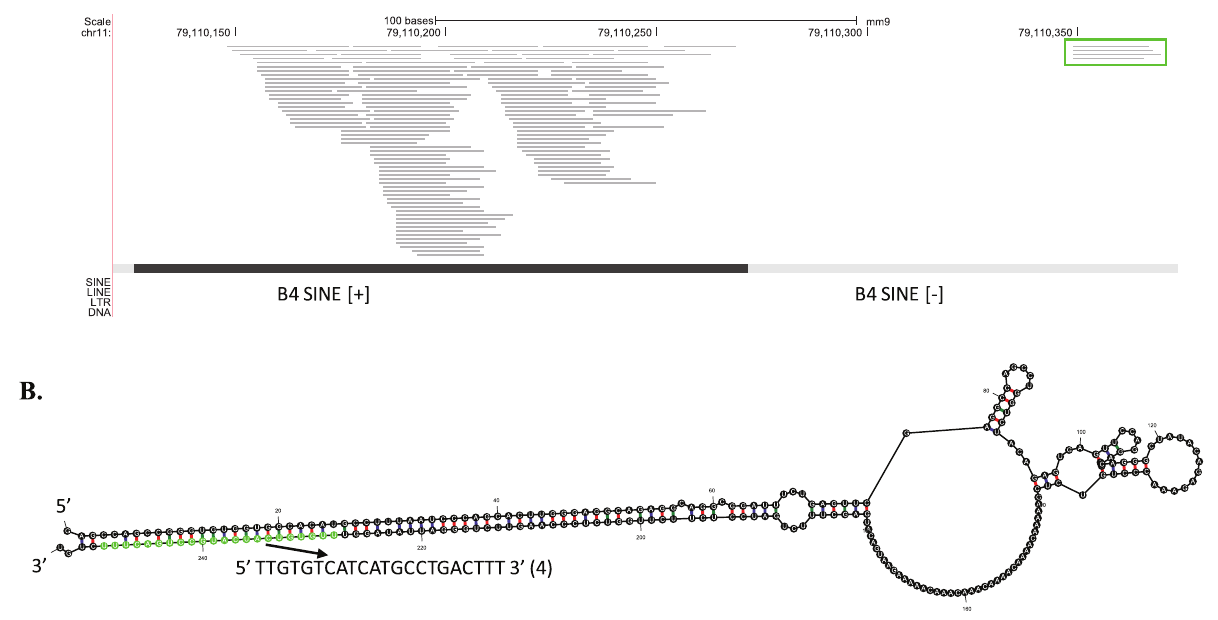
Figure 3. An endo-siRNA derived from tandem inverted B4 SINEs. (A) Alignment of reads to the mouse genome (mm9) and genomic conformation of the two inverted B4 SINEs. The green box indicates the identified siRNAs uniquely mapped to this SINE. The dark black line represents the well-conserved SINE compared to the consensus, while less conserved SINEs are in light gray. The symbol ‘‘ + ’’ and ‘‘ 2 ’’ indicate the orientation of the SINEs. (B) Folding structure of a transcript comprising the two B4 SINEs with the novel endo-siRNA annotated in green.